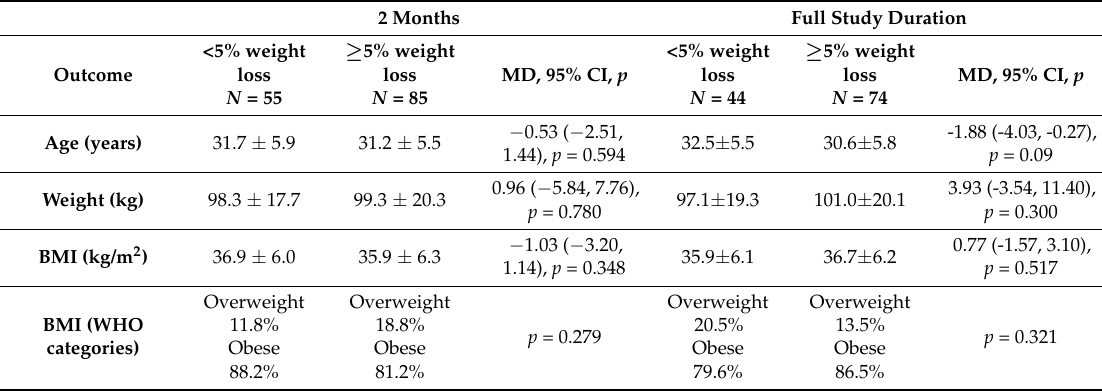
Table 3. Characteristics of study participants according to weight loss